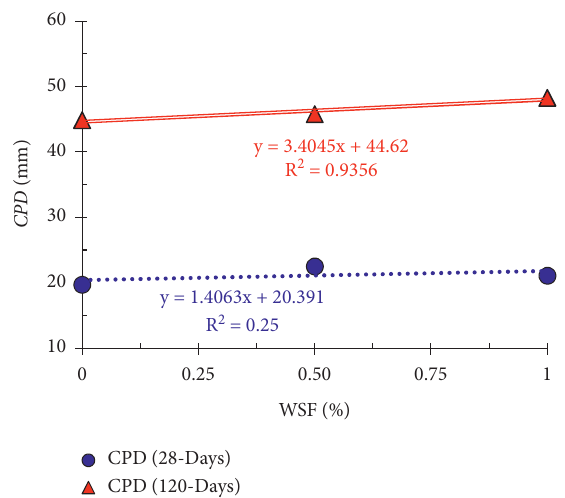
Figure 22: Relationship between WSF content and corresponding CPD values of HSC.